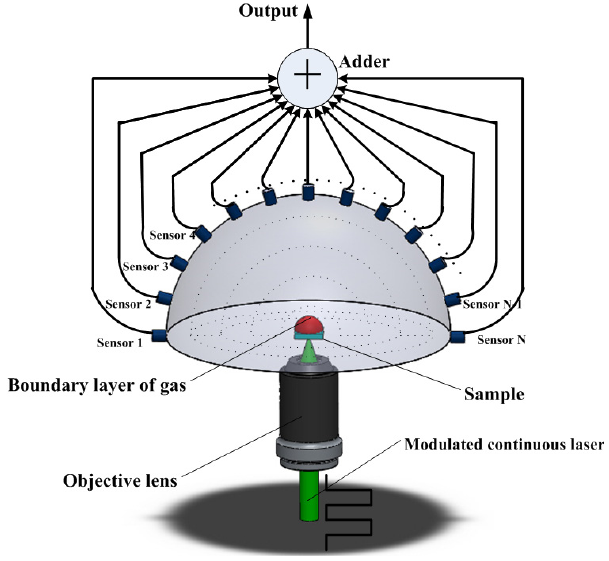
Fig. 1. Principle of simultaneous multi-probe microscopy with a PA